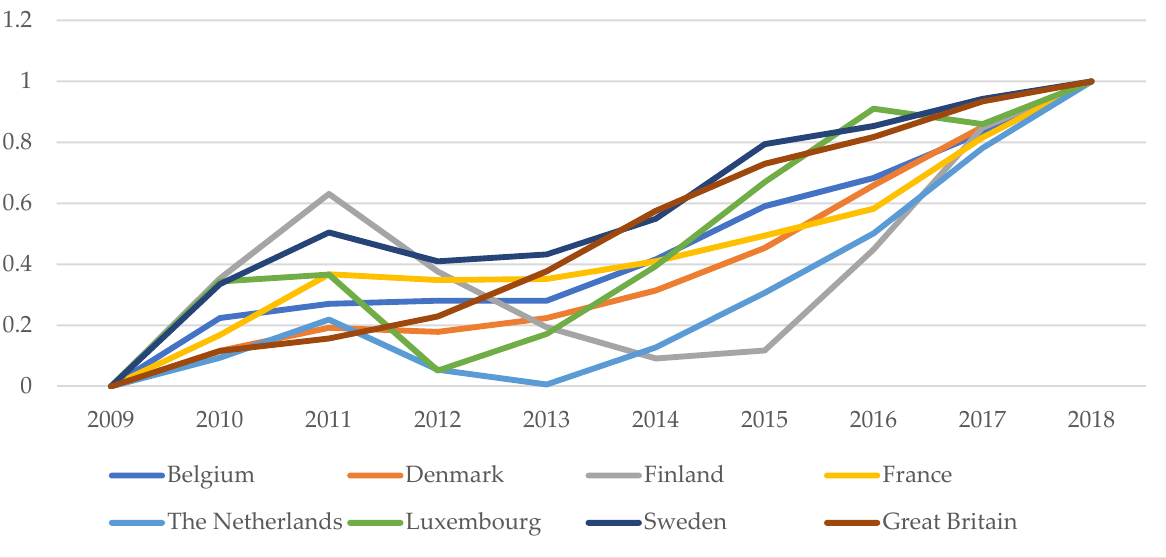
Figure A4. Trends in GDP in 2009–2018, TOPSIS value index. Source: Reproduced from [16], Eurostat: 2009—2018